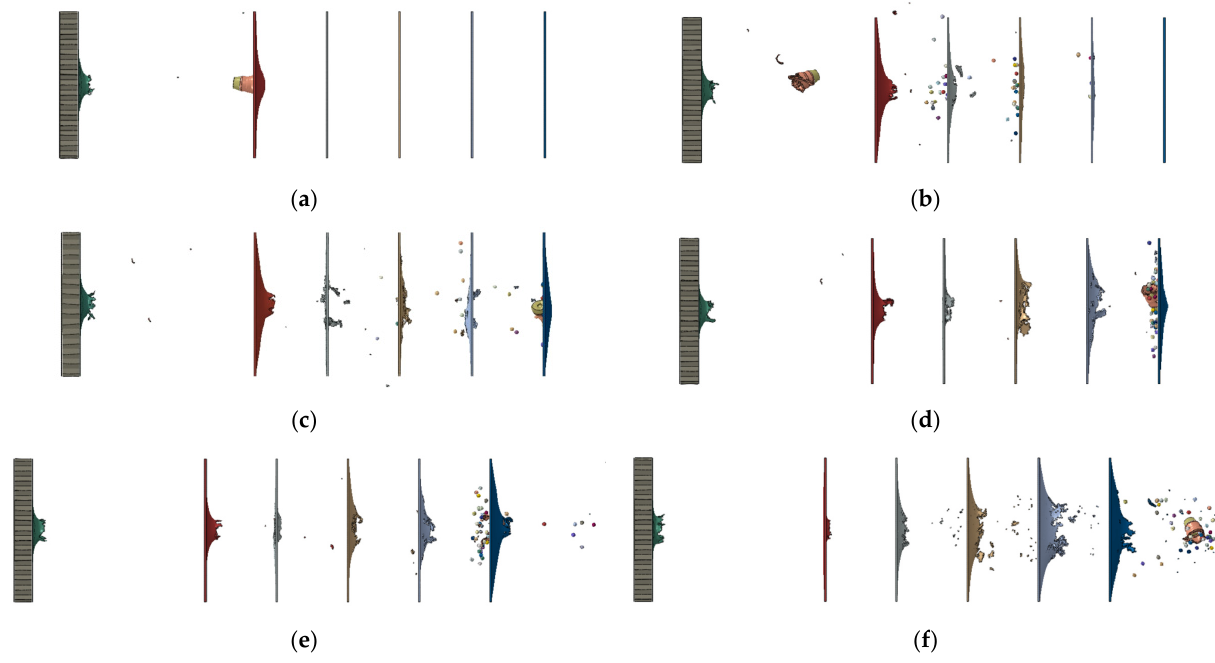
Figure 10. Damage effect of the kinetic projectile impact under different initial